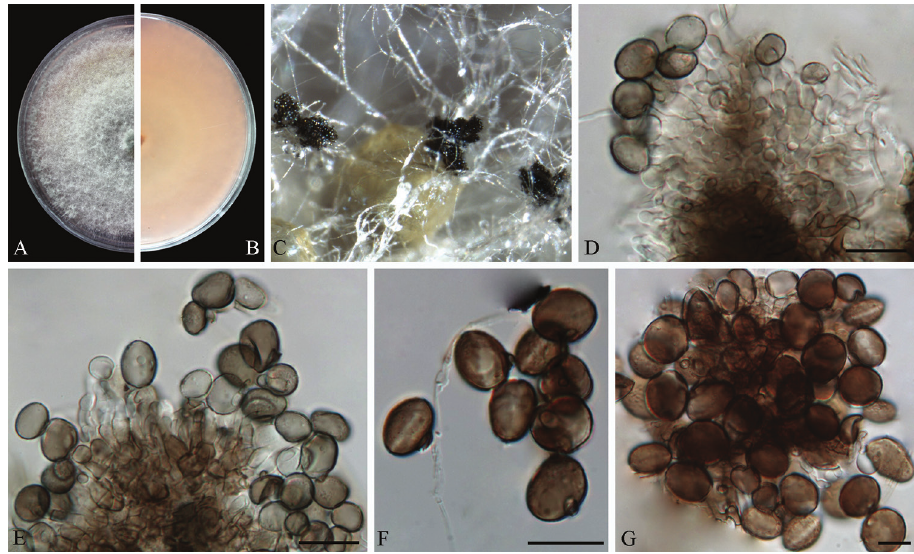
Figure 10. Arthrinium subroseum (from ex-holotype strain CGMCC3.18337) A–B 10 d old cultures on PDA C Colony on MEA producing conidia masses D–E Conidiogenous cells giving rise to conidia F–G Conidia. Scale bars = 10